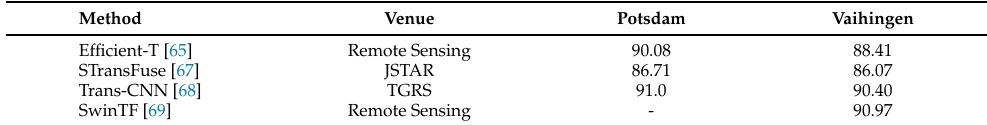
Table 4. Performance comparison, in terms of overall accuracy (OA), of different transformer-based semantic segmentation methods on two popular benchmarks: Potsdam and Vaihingen.